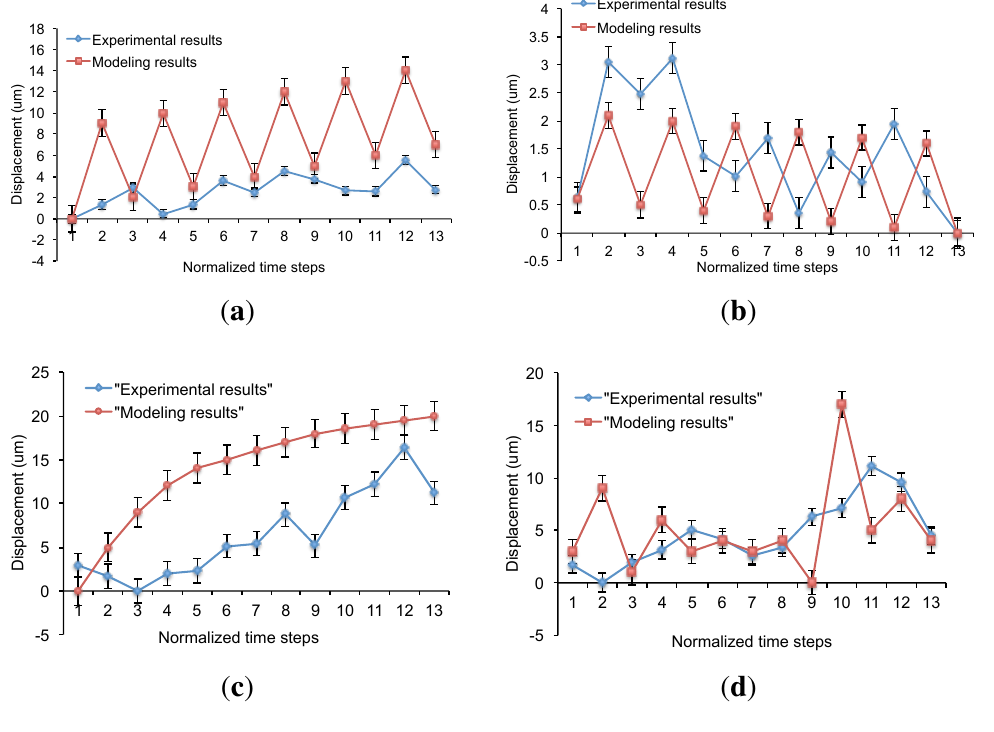
Figure 19. 2D experimental result comparison for ( a ) X and ( b ) Y axes in the case of 4-electrode architecture and ( c ) X and ( d ) Y axes in the case of 8-electrode